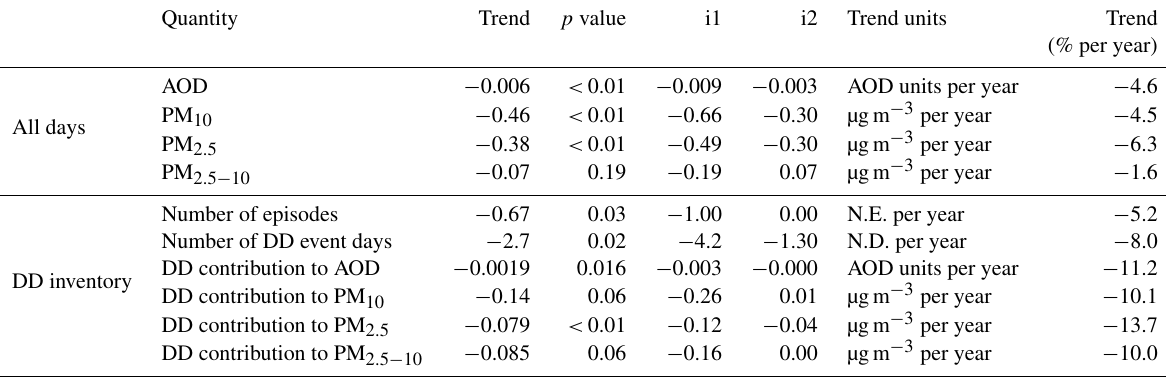
Table 3. Temporal trends (Theil–Sen estimator), p value, and confidence interval ([i1, i2]) given by the quantities considered for all days and for the contribution of DD. For the DD inventory the number of episodes and DD event days is also included. Negative trend means a decrease in the quantity analysed.